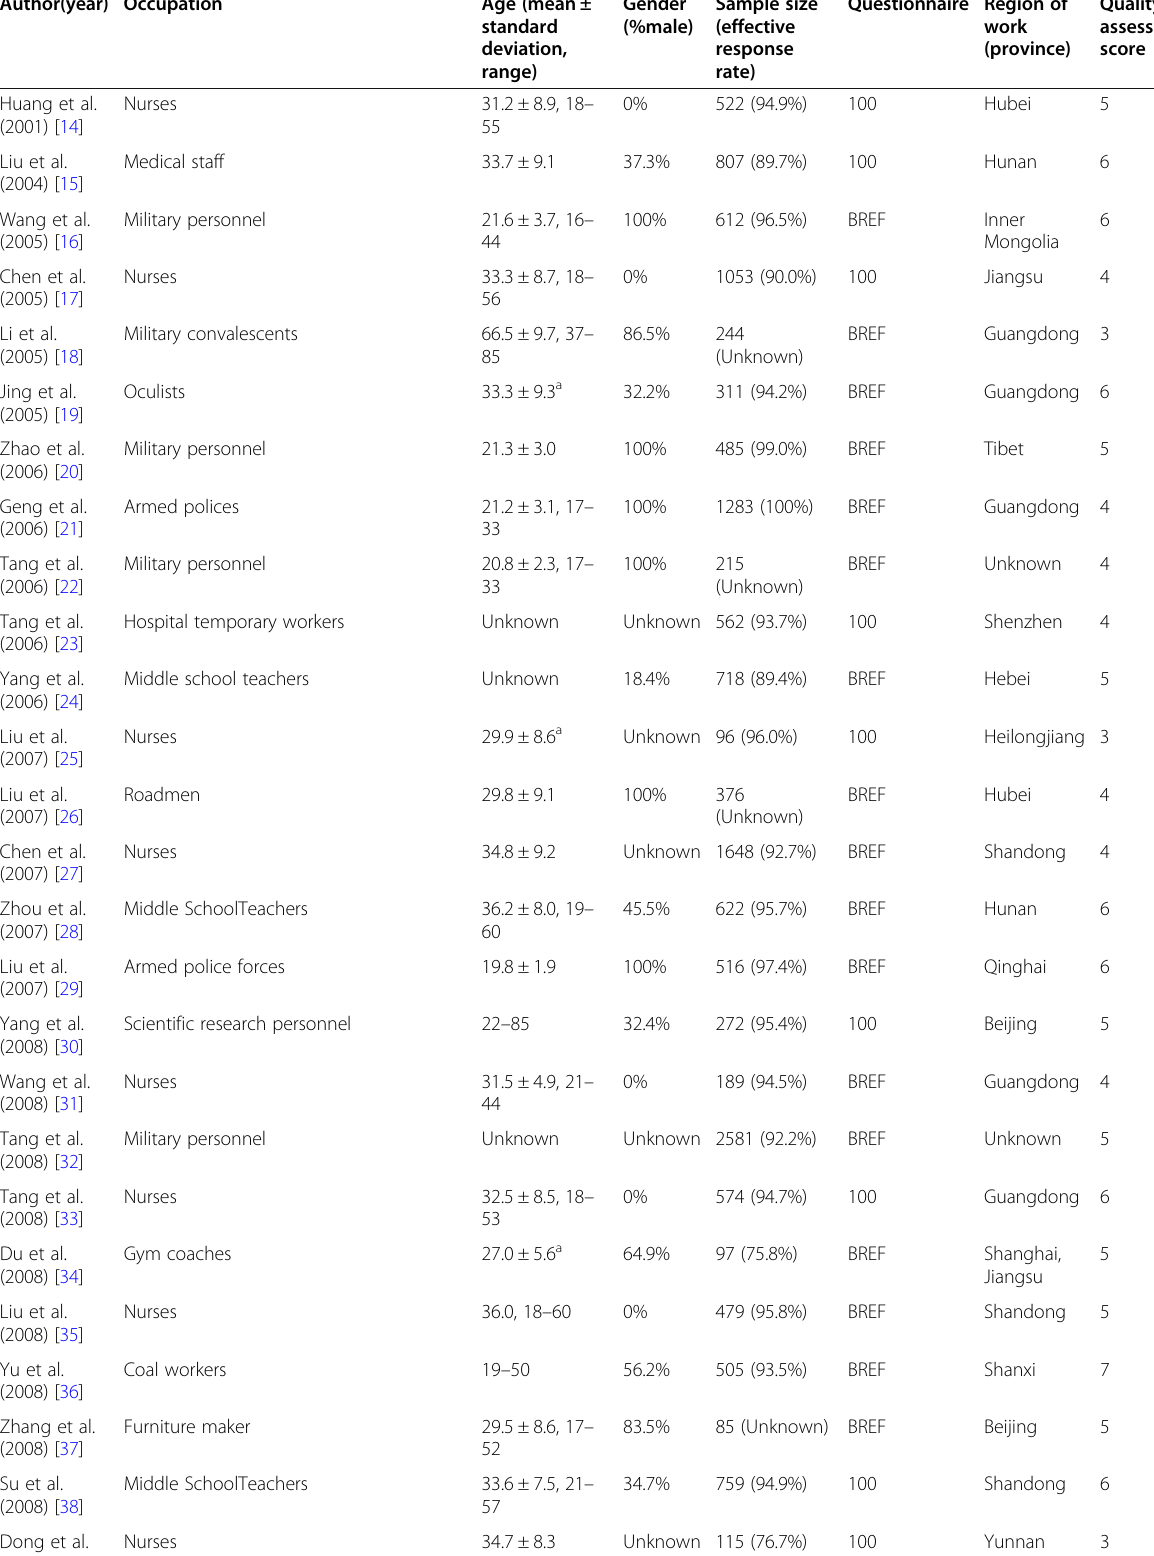
Table 2 Descriptive characteristics and quality assessment of the included